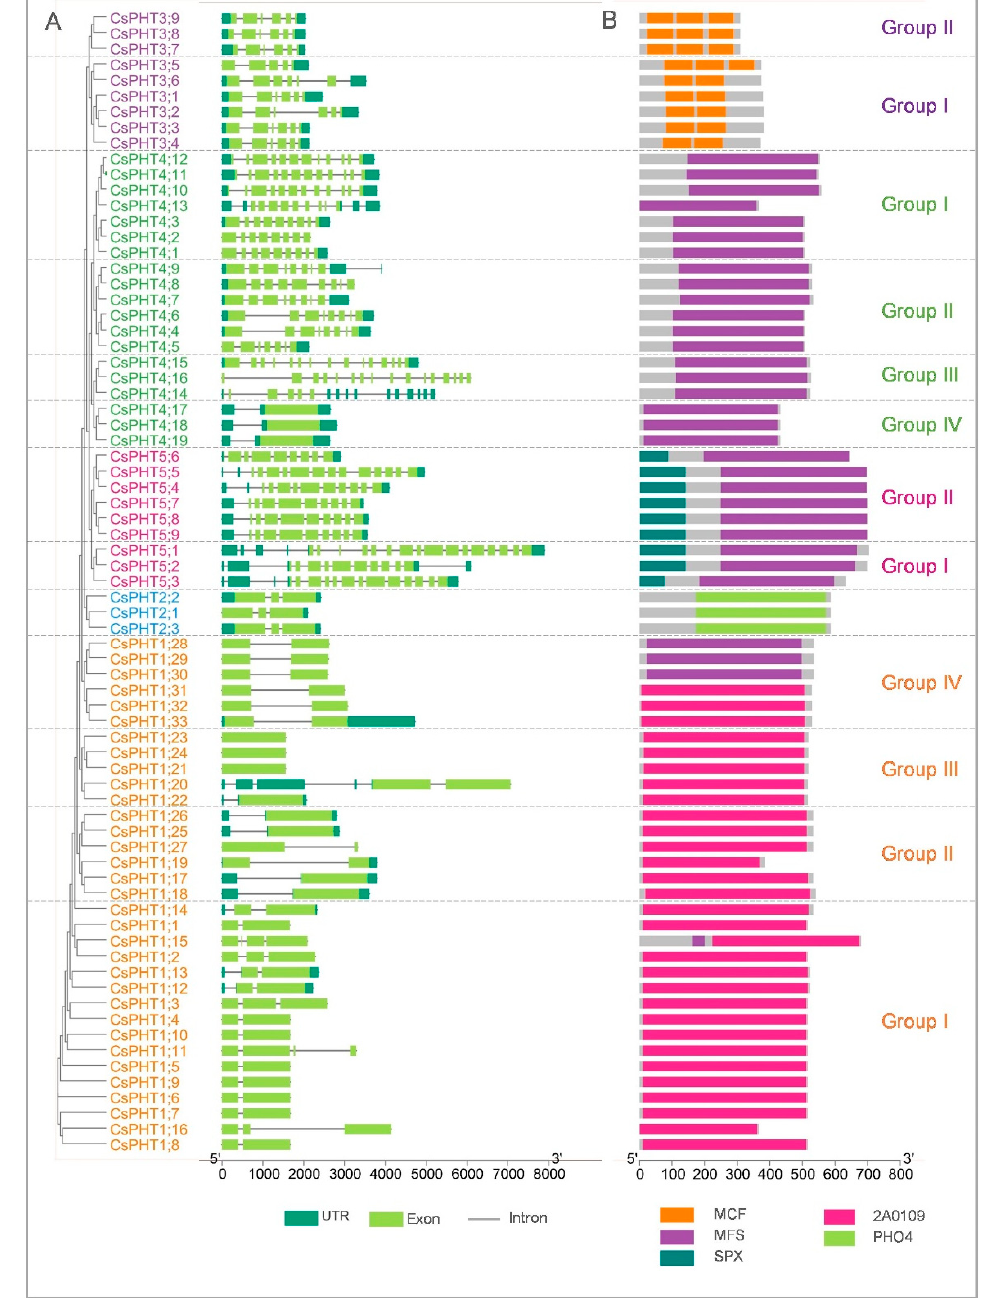
Figure 3. ( A ) Gene structures and ( B ) conserved protein domains of CsPHT members. The intron/exon structures were built using Camelina genome annotation file [38]. The protein domains were searched in NCBI-CDD database [50]. The graphics were generated using TBtools [48].